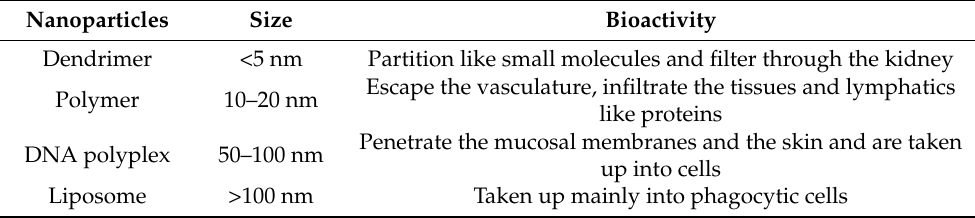
Table 2. The relationship between nanoparticle size and bioactivity.